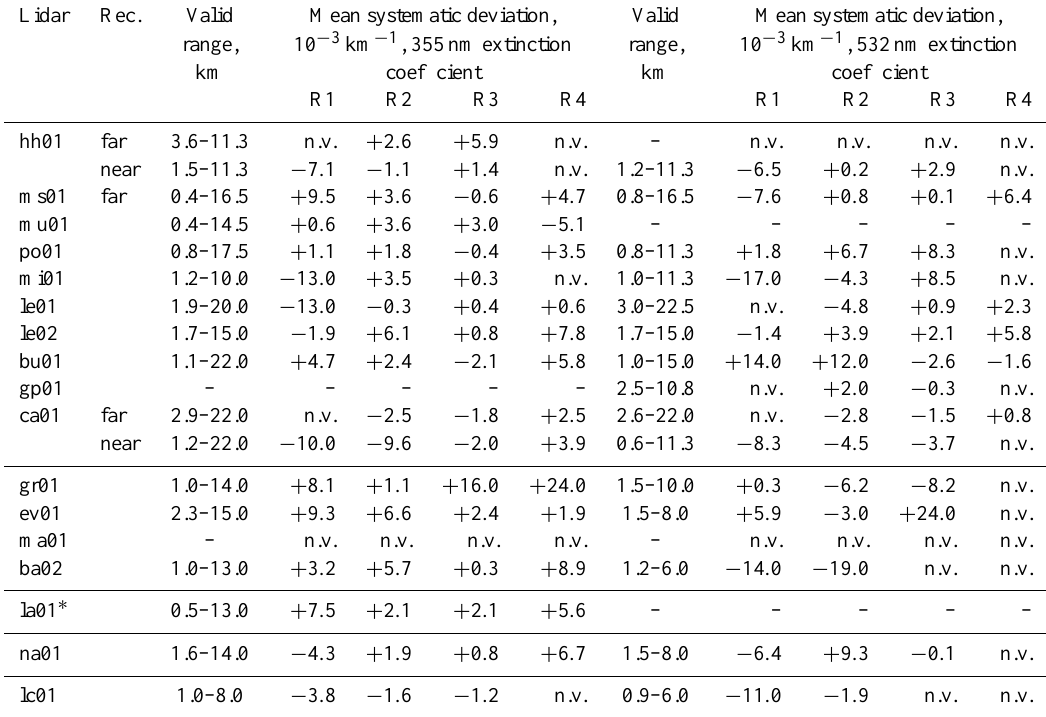
Table 5. Valid range and mean systematic deviation of particle extinction coefficients at 355 and 532nm in four height ranges: R1 (lowest valid range–2.5km), R2 (2.5–6km), R3 (6–12km), and R4 (12km–highest valid range). n.v. denotes not valid. Rec. denotes receiver